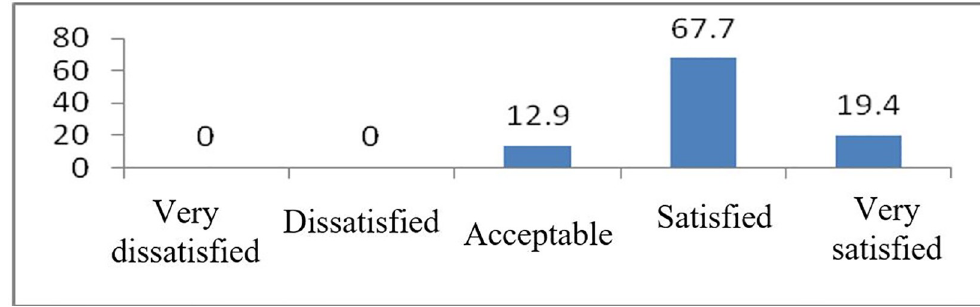
Fig 2. Level of satisfaction with the surgical outcomes of microtia reconstructive